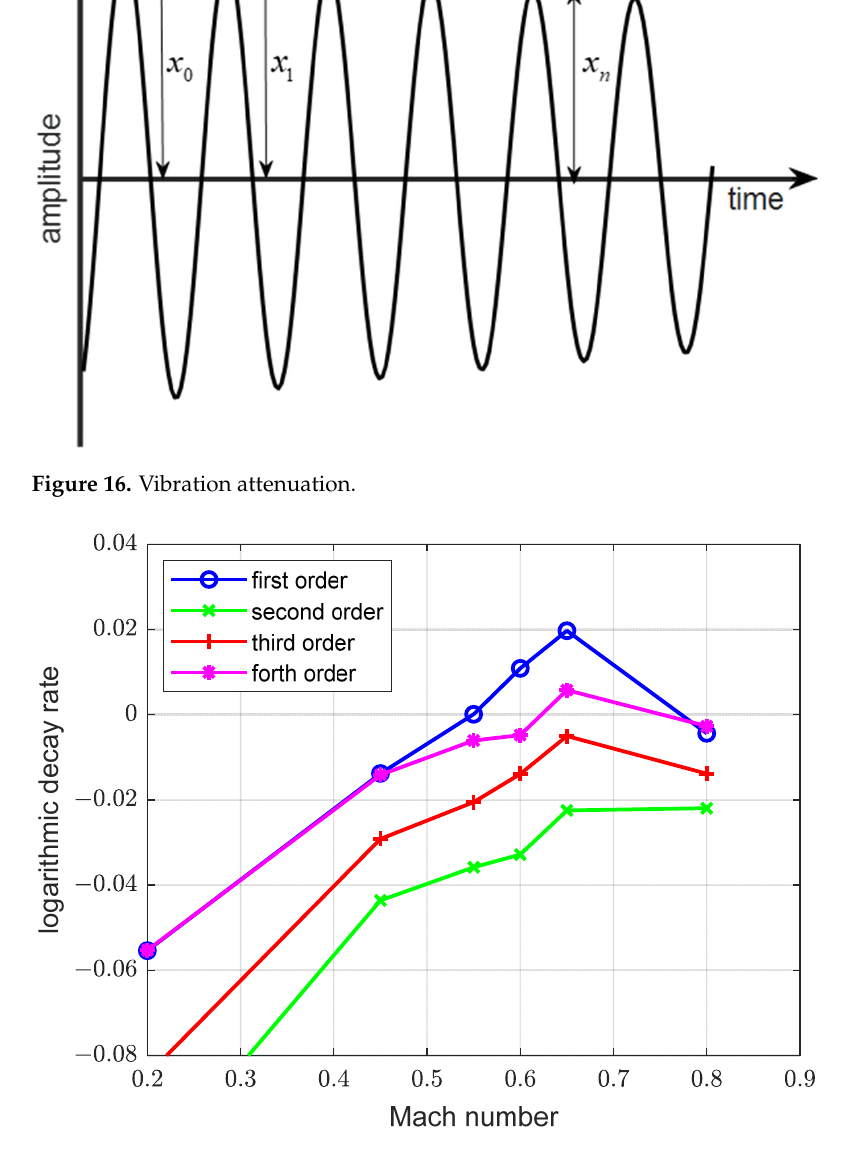
Figure 17. The logarithmic decay rate of the generalized displacement varies with varying Mach numbers ( p = 600 Pa, α = 90 ◦